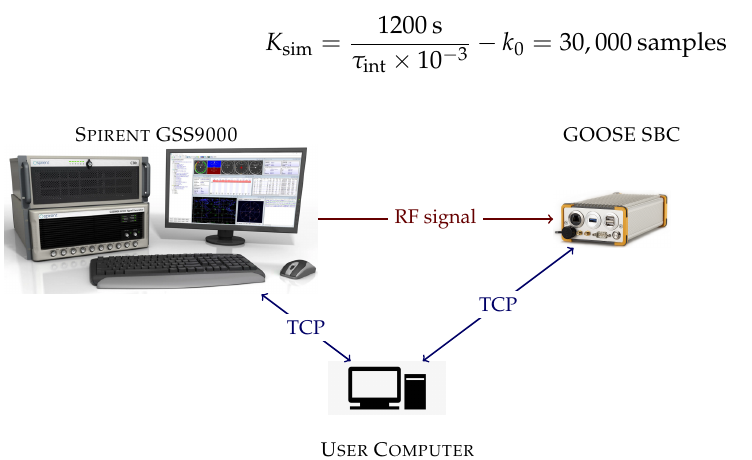
Figure 7. Evaluation setup consisting of a Spirent RFCS, a GOOSE SBC receiver, and a control computer.